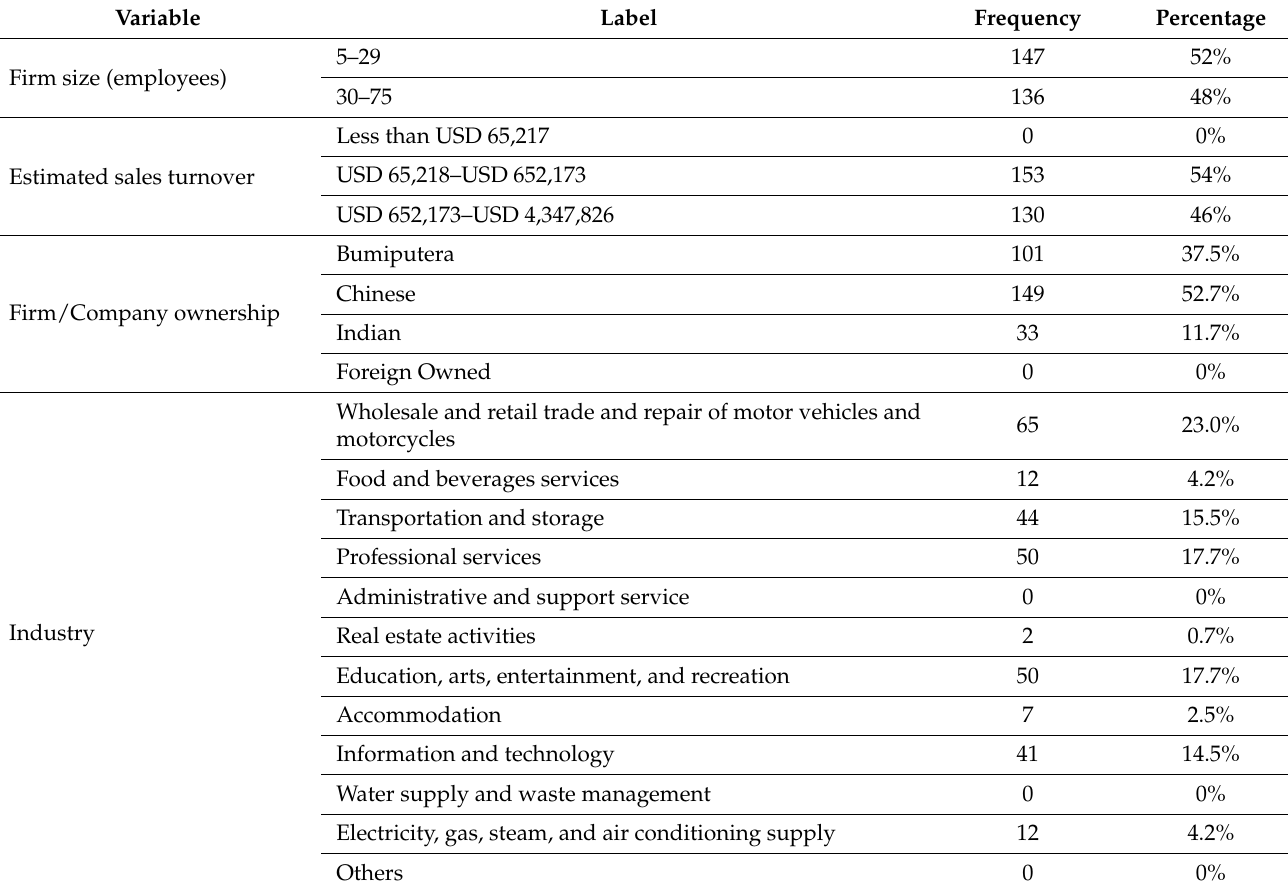
Table 1. Demographic Statistics.